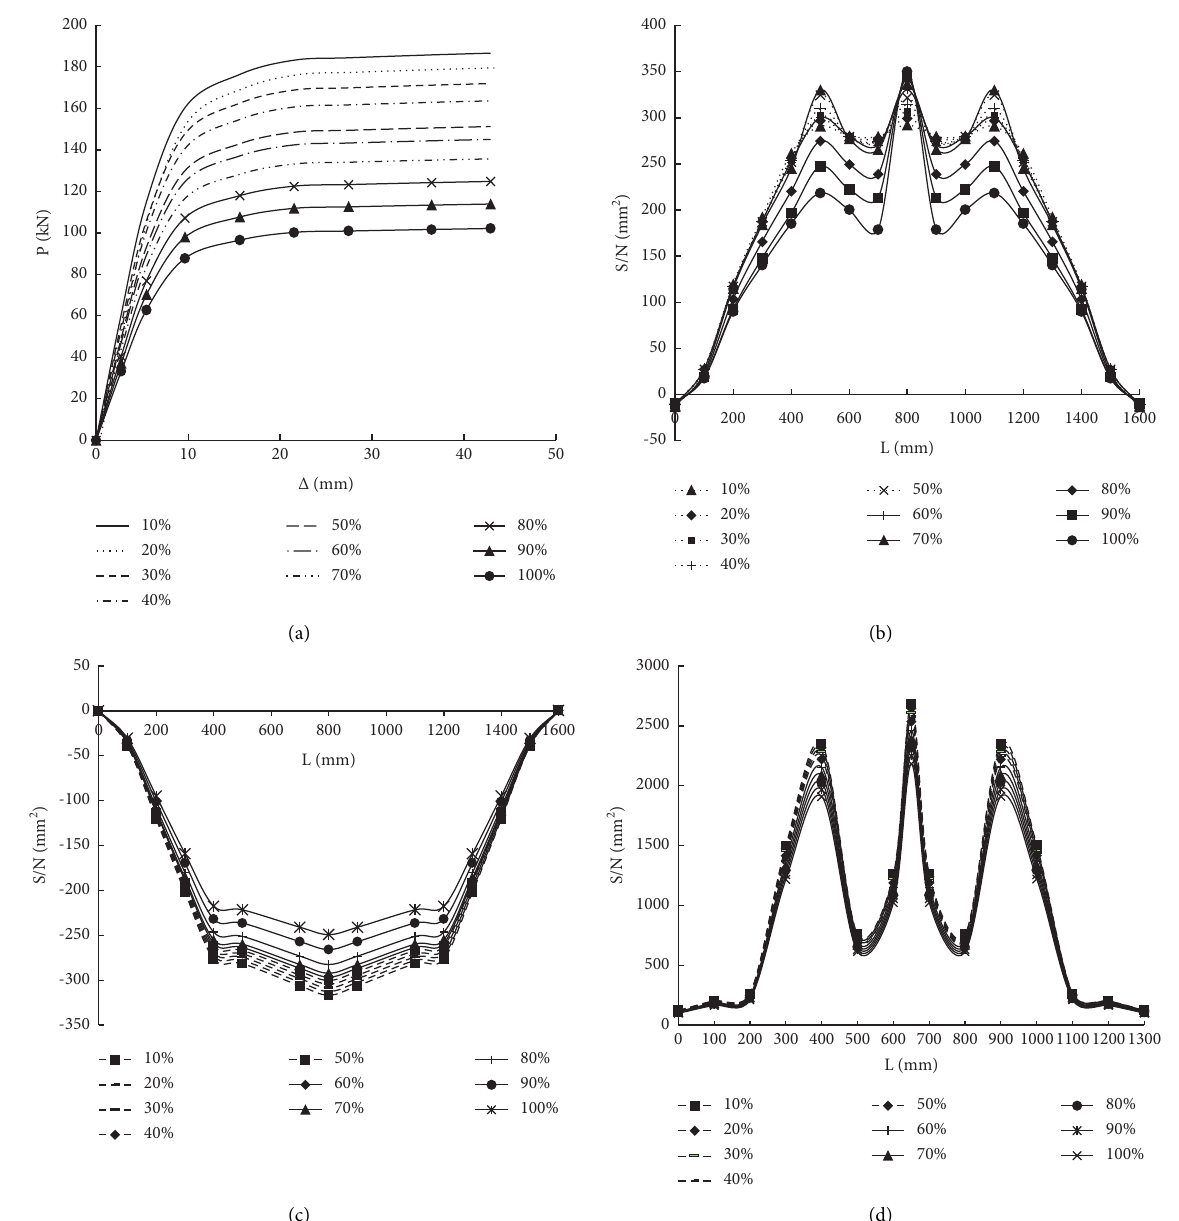
Figure 14: Effect of corrosion. (a) Load and deflection. (b) Stress along steel beam length. (c) Stress along steel beam width. (d) Stress along CFRP sheet’s